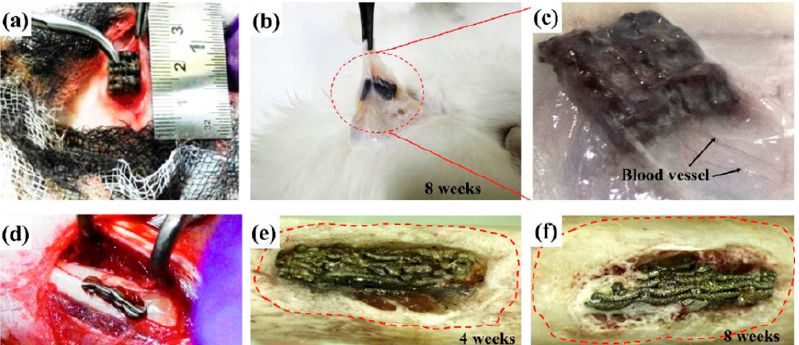
Figure 9. ( a ) Subcutaneous implantation of a 3DPed porous Ti-6Al-4V scaffold in rabbit model; ( b ) scaffold in the rabbit tissue after 8-week implantation; ( c ) magnified view of the circled region in (b), showing the tissue and blood vessel formation around the scaffold; ( d ) scaffold implantation in rabbit’s femur and bone in-growth around the scaffold after ( e ) 4 weeks and ( f ) 8 weeks [107] (reproduced with permission number: 5071080659903, Elsevier).